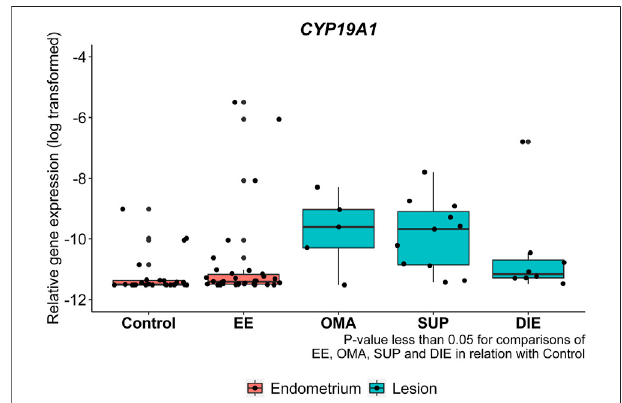
FIGURE 2 | CYP19A1 mRNA expression from endometriotic samples. Gene expression levels of CYP19A1 were analyzed by real-time polymerase chain reaction in eutopic endometrium from control patients (control), eutopic endometrium from endometriosis patients (EE), and in ovarian (OMA), super fi cial (SUP), and deep-in fi ltrating (DIE) lesions. Relative gene expression levelswerenormalizedby GAPDH .Barsrepresentthelog 10